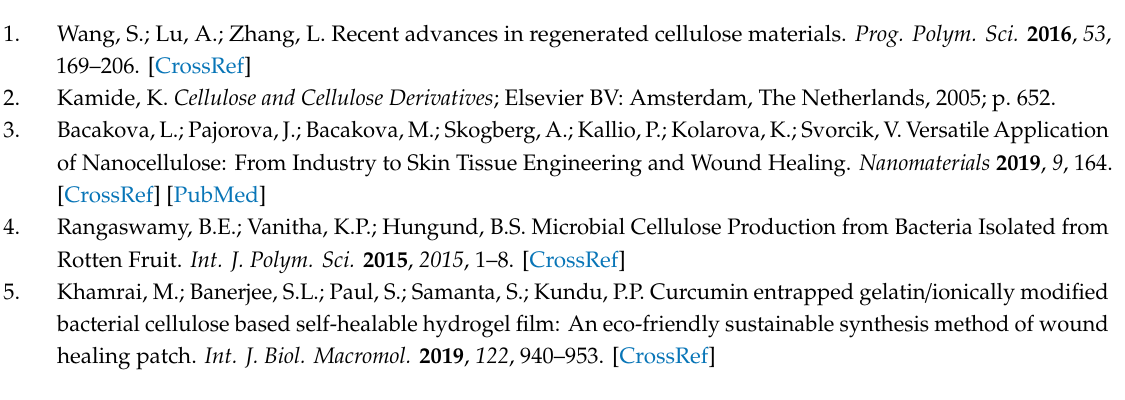
Figure S1: Figure S1. Mitochondrial activity of human dermal fibroblasts grown in a pure cultivation medium and in media with unmodified curcumin (C), or with curcumin degraded at 180 ◦ C (DC 180) or at 300 ◦ C (DC 300) in various concentrations (0.01, 0.05, 0.1, and 0.5 mg / mL) on day 1 after adding the agent. Arithmetic mean ± SD from 4 measurements, ANOVA, Student–Newman–Keuls method. Statistical significance ( p ≤ 0.05; depicted above the columns): * compared with cells cultivated in the pure medium; C or DC 300 compared with cells cultivated in the medium with C or DC 300 of the same concentration, Figure S2. Morphology of human dermal fibroblasts grown in a pure cultivation medium and in media with unmodified curcumin (C), or with curcumin degraded at 180 ◦ C (DC 180) or at 300 ◦ C (DC 300) in various concentrations (0.01, 0.05, 0.1, and 0.5 mg / mL) on day 1 after adding the agent. The cells were stained with phalloidin-TRITC (red; F-actin cytoskeleton) and with DAPI (blue; cell nuclei). Olympus IX 51 microscope, obj. 10 × , DP 70 digital camera, Figure S3. Morphology of human dermal fibroblasts on pristine bacterial nanocellulose (BC) and on nanocellulose loaded with pure curcumin (BC + C), or with curcumin degraded at 180 ◦ C (BC + DC 180) or at 300 ◦ C (BC + DC 300) at various concentrations (0.05, 0.1, and 0.5 mg / mL) on day 3 after cell seeding. The cells were stained with phalloidin-TRITC (red; F-actin cytoskeleton) and with DAPI (blue; cell nuclei). Olympus IX 51 microscope, obj. 10 × , DP 70 digital camera, Table S1. The functional groups responsible for IR